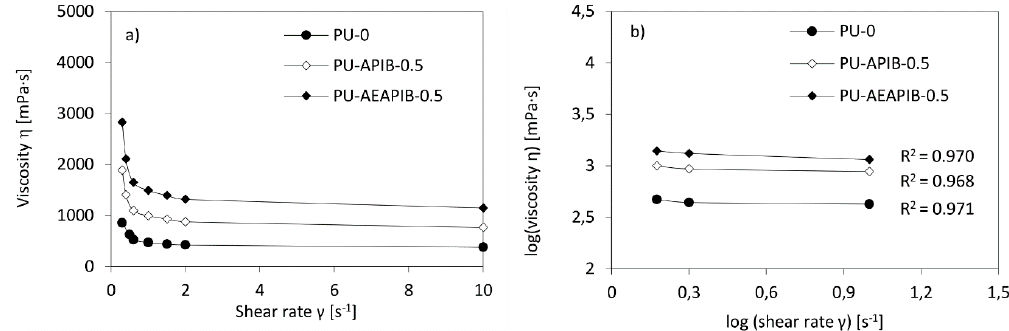
Figure 4. ( a ) Viscosity as a function of shear rate and ( b ) log-log plot of the viscosity vs. shear rate for the selected polyol premixes. the selected polyol